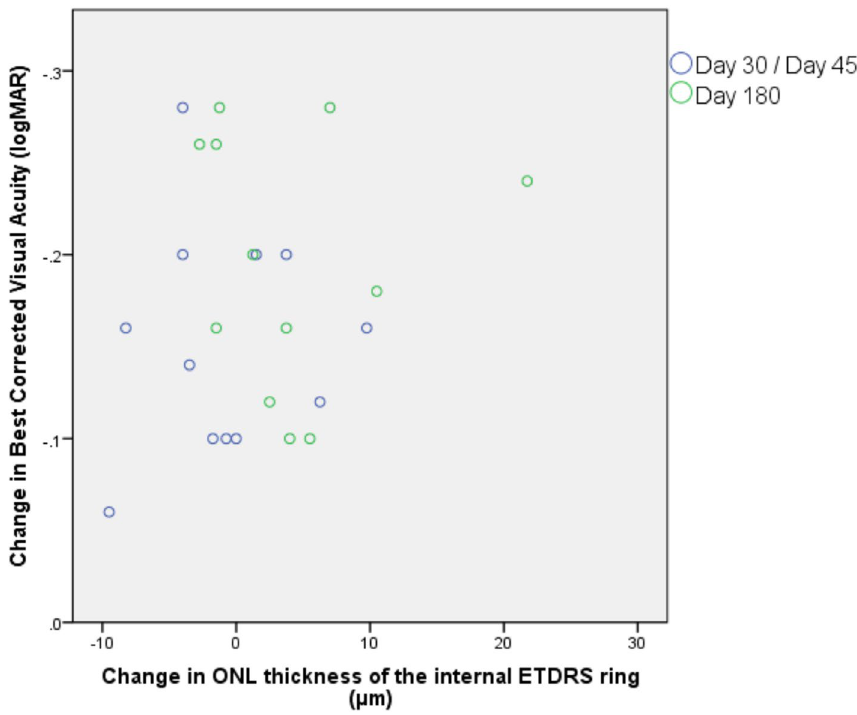
Figure 2. Scatterplot of changes over the 6-month follow-up in best-corrected visual acuity (BCVA) versus changes in outer nuclear layer (ONL) thickness of the internal Early Treatment Diabetic Retinopathy Study (ETDRS) ring.